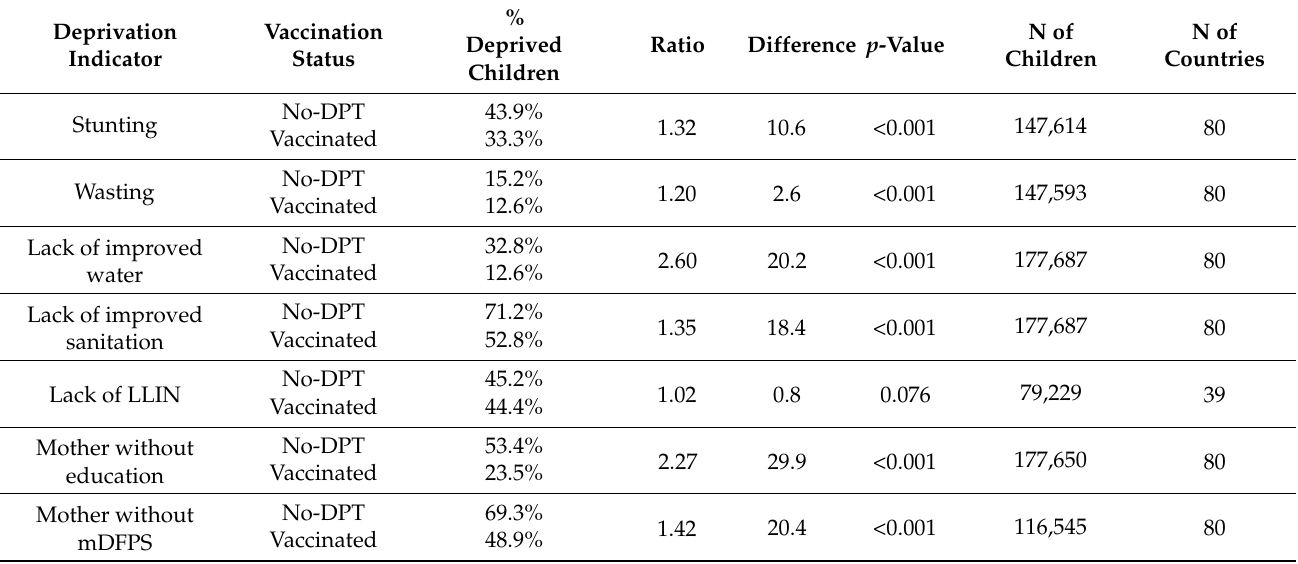
Table 1. Prevalence of deprivation indicators according to vaccination status. Individual-level analyses pooled over 80 countries.